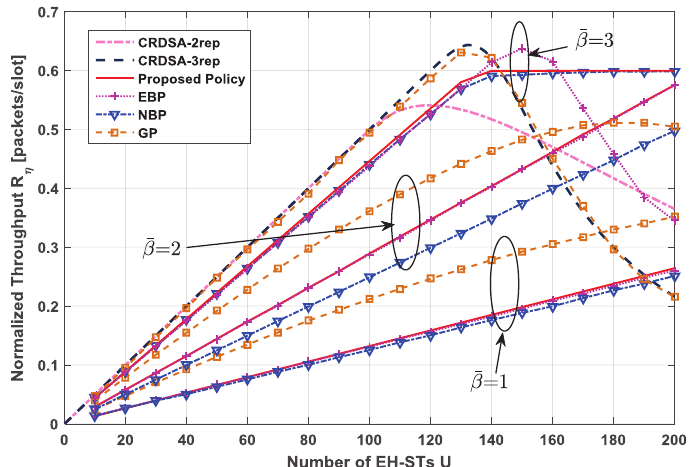
Figure 5. Normalized throughput of different policies comparison for different network sizes, under different EH rates ¯ β ∈ { 1,2,3 } , e max = 10. For RA schemes, number of time slots in each frame N = 200, QPSK modulation, E s / N 0 = 10